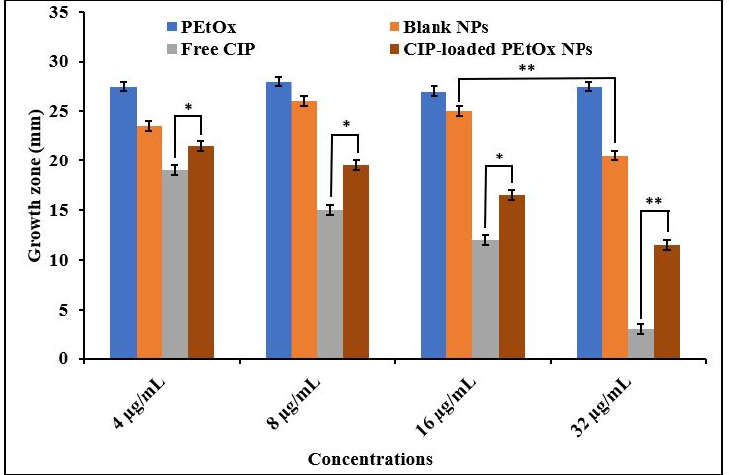
Figure 1. Bactericidal effects of PEtOx, blank NPs, free CIP, and CIP-loaded PEtOx NPs against S. aureus . p > 0.05 (*), p < 0.05 (**).